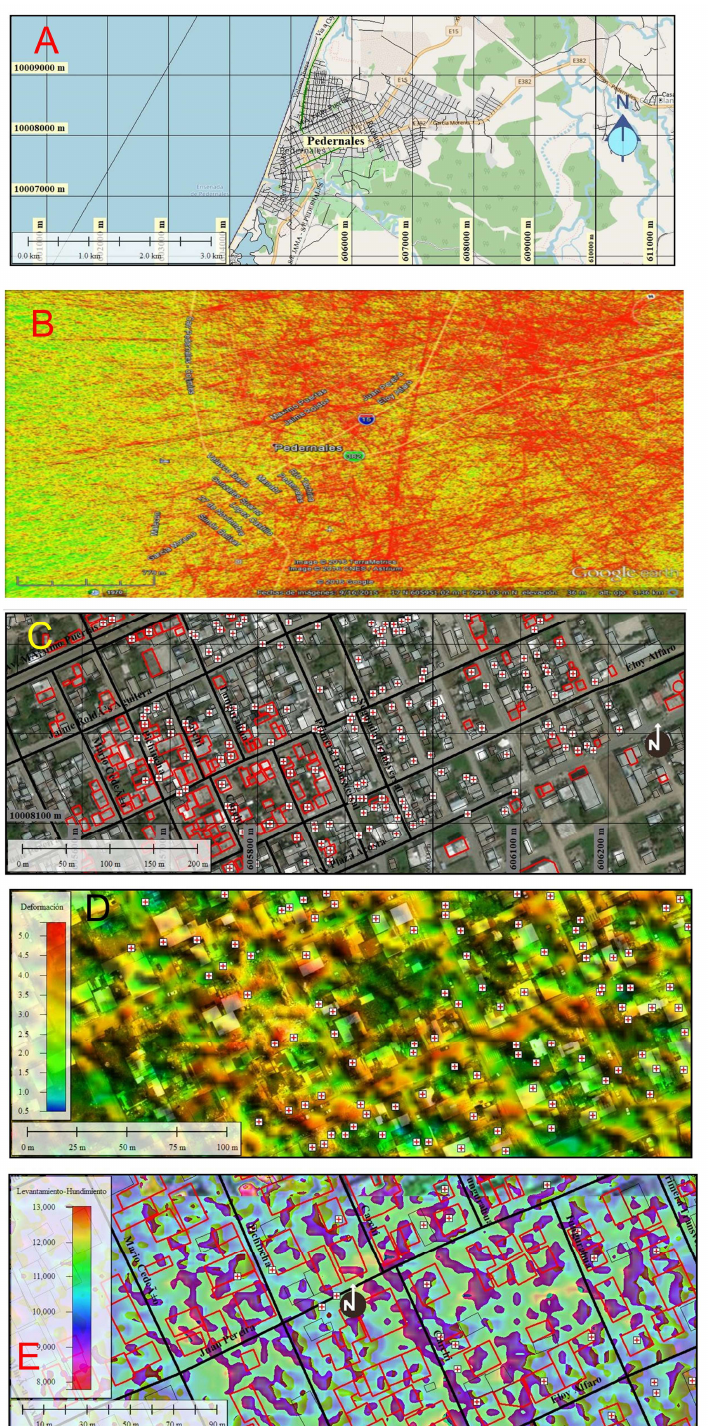
Figure 8. ( A ) Location of Zone 2 in Pedernales. ( B ) Structural lineaments obtained with the proposed methodology. ( C ) Orthophoto with the destroyed homes (red polygons) after the earthquake of 2016. ( D ) Location of the collapsed houses on top of the obtained structural lineaments. ( E ) Color-intensity filter and collapsed houses (red color).